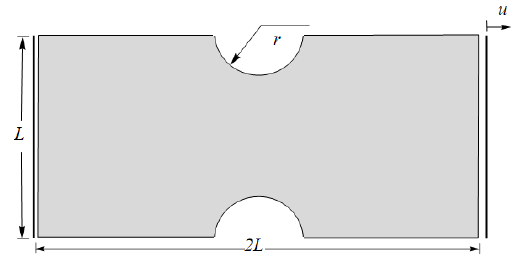
Figure 8. A-notched bar in tension. Geometry and boundary